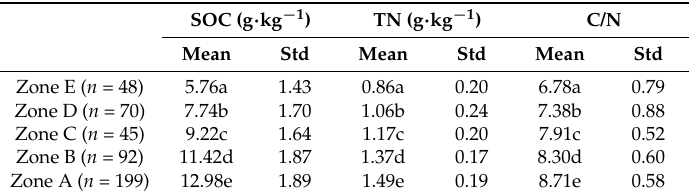
Table 3. SOC, TN, and C/N ratio of 454 soil samples.